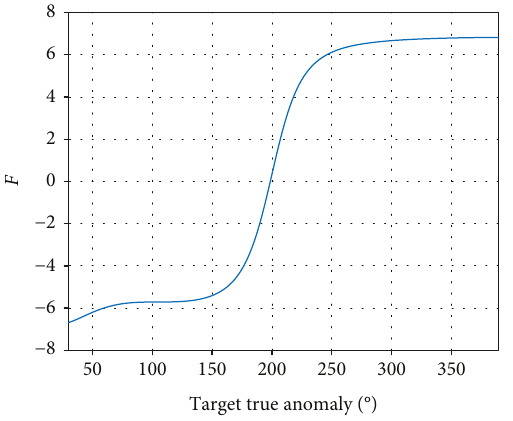
Figure 2: F value corresponding to the true anomaly of the target under di ff erent intercept points.